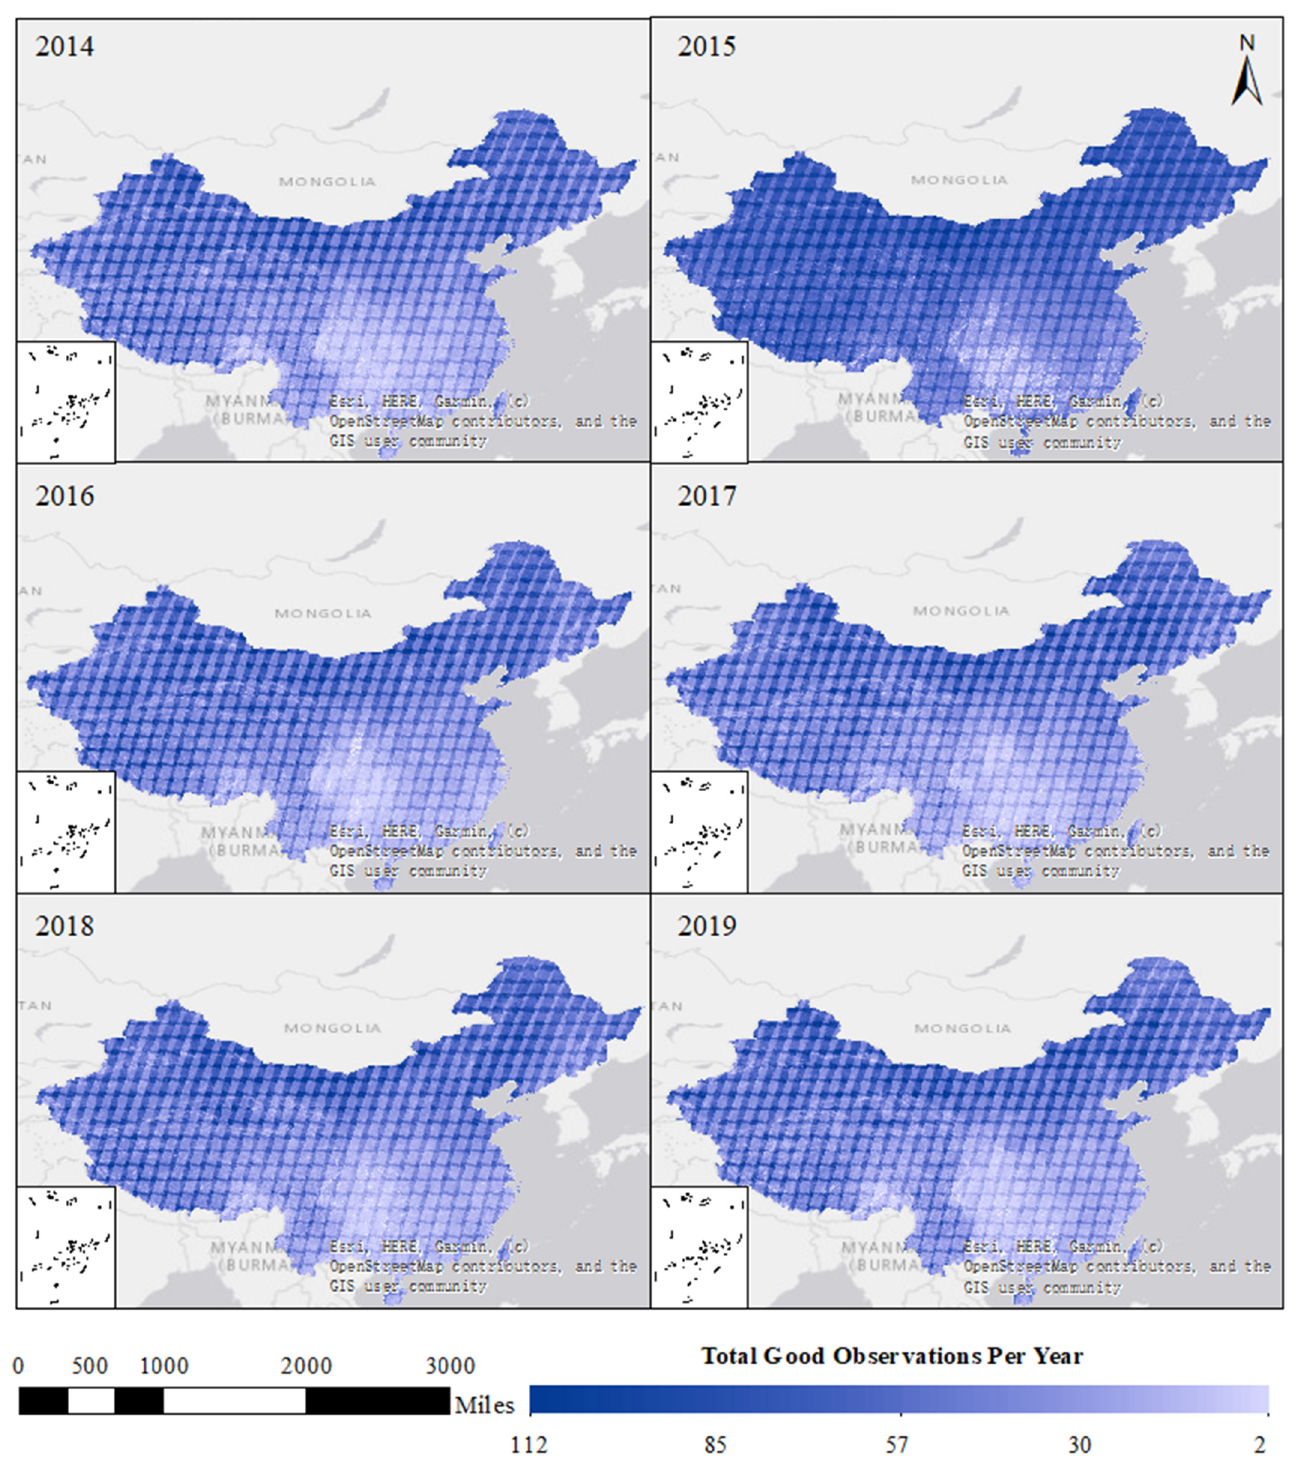
Figure 2. Availability of good observations per year from 2014 to 2019.